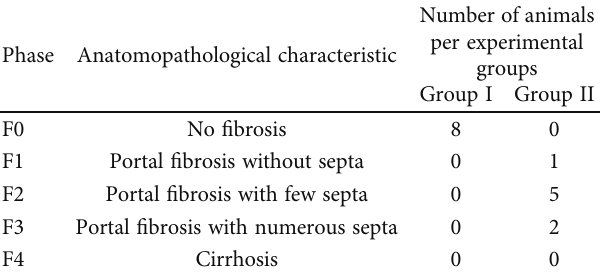
Table 3: Grading of histological lesions according to experimental groups using the METAVIR